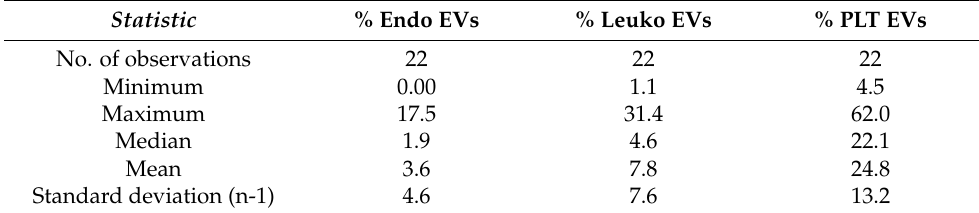
Table 2. Proportion of EVs subtypes in healthy PB